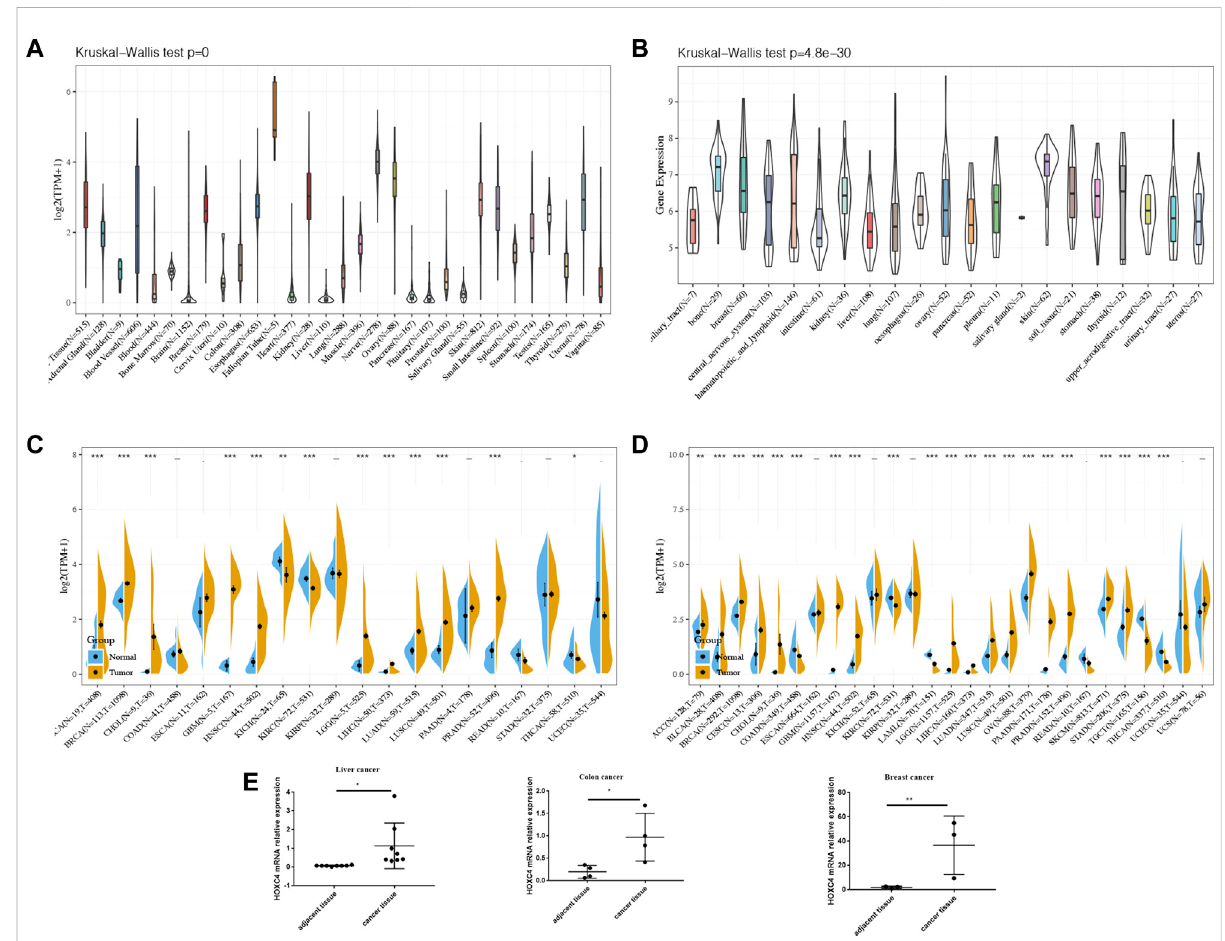
FIGURE 1 HOXC4 expression in pan-cancer. (A) Expression levels of HOXC4 in GTEx dataset. (B) Expression levels of HOXC4 the CCLE base. (C) Expression levels of HOXC4 in TCGA database. (D) HOXC4 expression difference in tumors combined with data of normal tissues I GTEx database and data of TCGA tumor tissues. (E) qRT-PCR validation of HOXC4. Cancer vs. adjacent tissue samples from liver cancer, colon cancer and breast cancer patients respectively.* p < 0.05, “ p < 0.01, *" p <